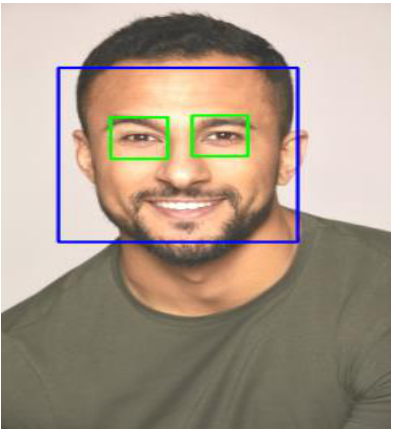
Figure 13. After increasing the brightness of Figure